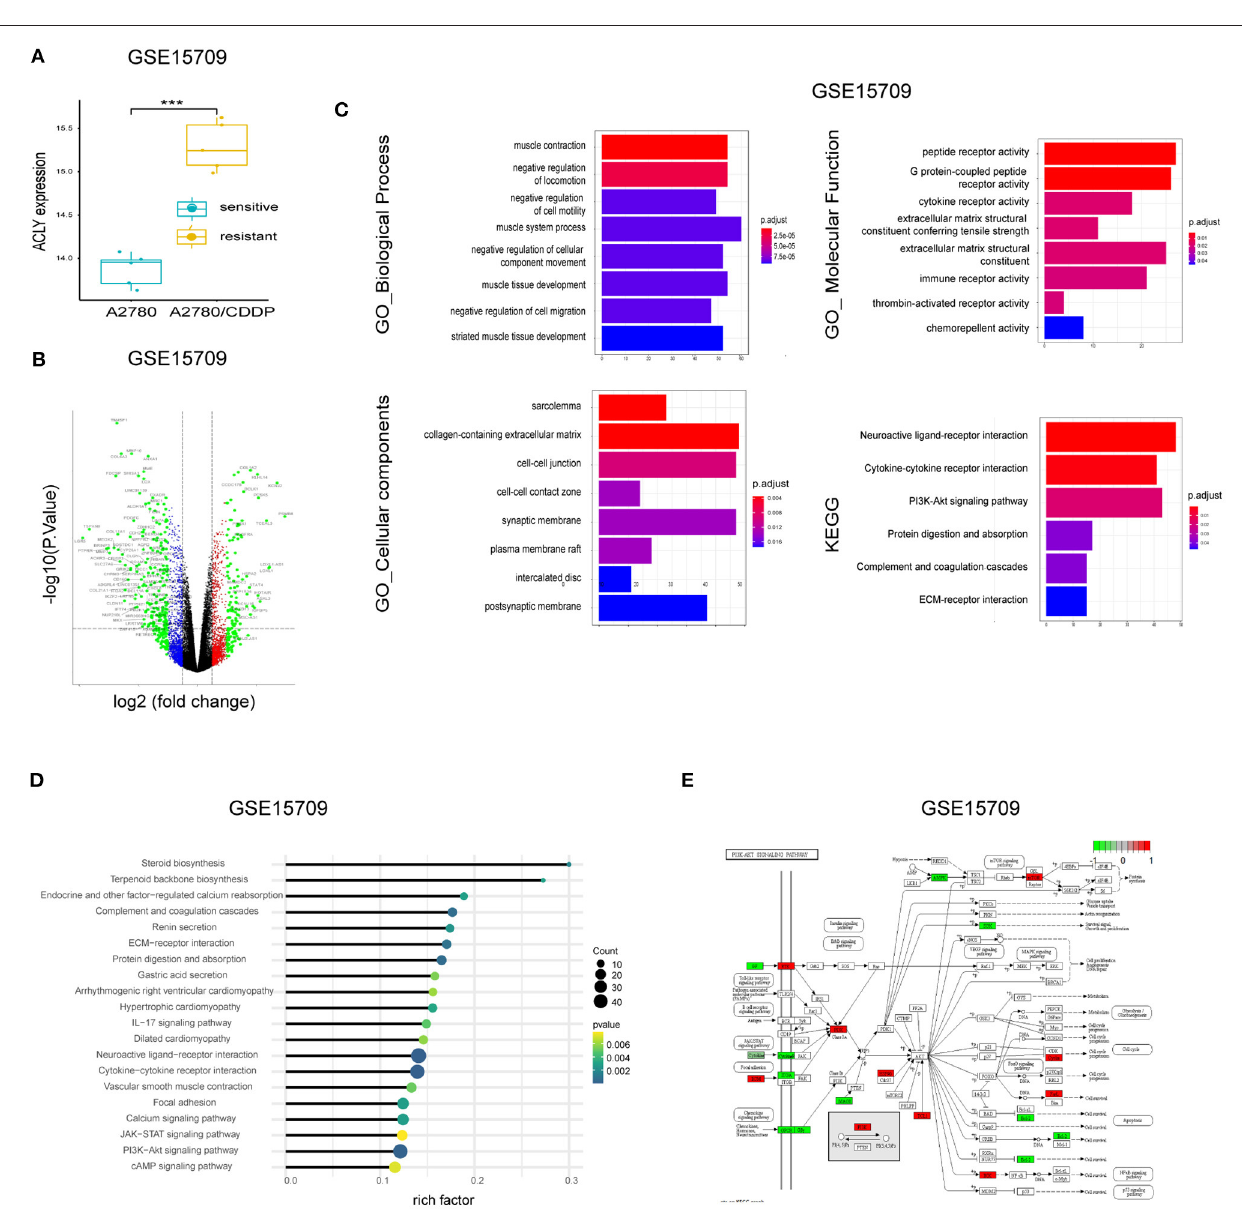
FIGURE 3 | Bioinformatic analysis showed ACLY is upregulated in A2780/CDDP cells. (A) ACLY was upregulated in A2780/CDDP cells compared with A2780 cells in GSE15709 dataset. (B) The volcano plot on DEGs between A2780 and A2780/CDDP in GSE15709 dataset. (C) The GO enrichment and KEGG enrichment of DEGs between A2780/CDDP and A2780, the filtering condition was p < 0.05. (D) KEGG enrichment of DEGs of GSE15709 calculated and weighted by rich factor. (E) Pathway viewer of PI3k/AKT, the red units mean upregulated in A2780/CDDP, and the green units mean downregulated in A2780/CDDP, the darker the color is, the less the P -value is. *** P < 0.001 for statistical analysis of the indicated groups.